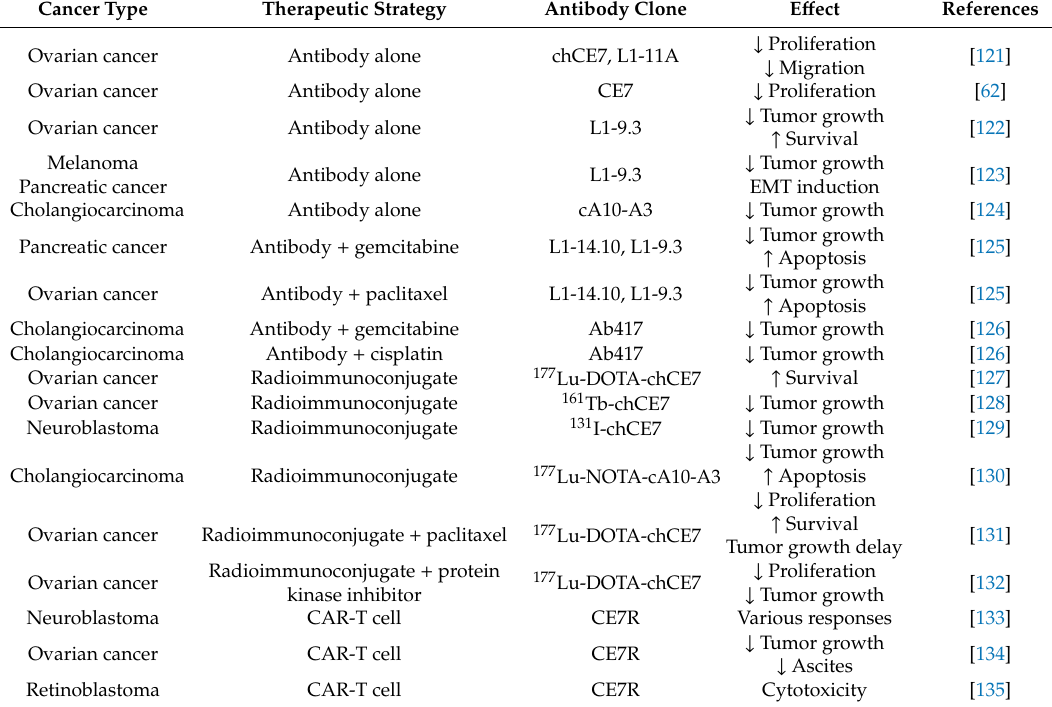
Table 3. L1CAM-targeted therapeutic approaches in di ff erent